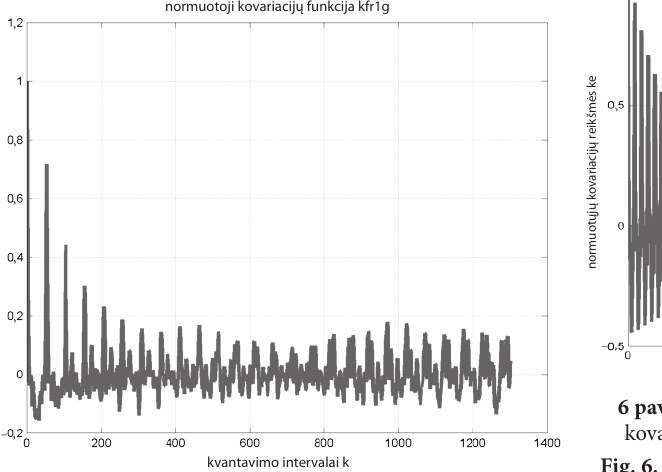
Fig. 6. Normalised covariance function of the Digital image 1nd fragment, applying RGB tenzor of all colours